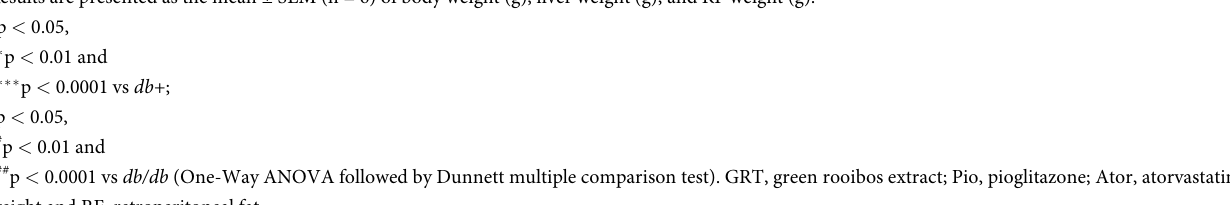
Results are presented as the mean ± SEM (n = 6) of body weight (g), liver weight (g), and RF weight (g).